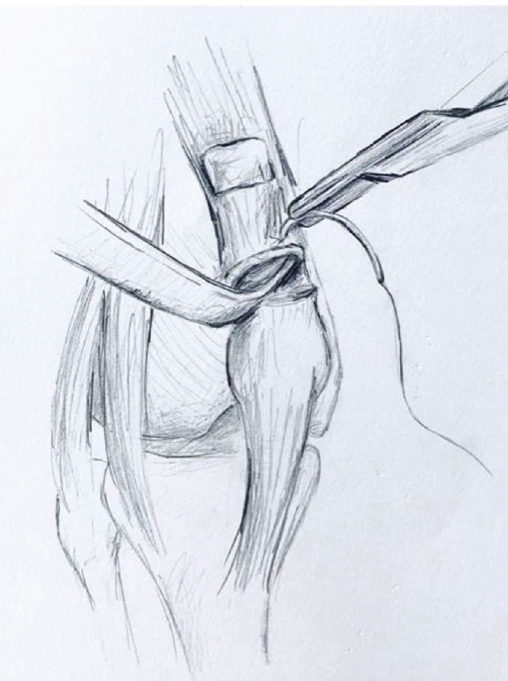
Figure 8: Illustration of proximal mesh fi xation and preparation of remaining quadriceps